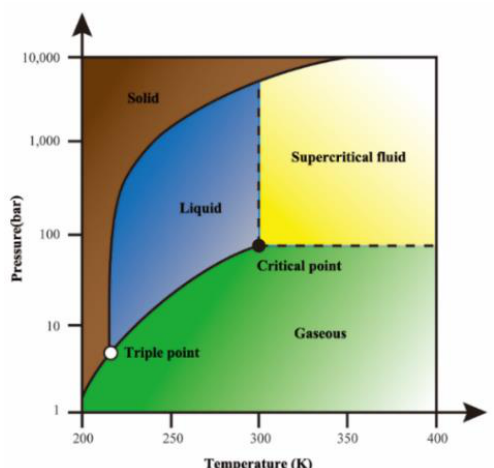
Figure 2. Phase diagram of carbon dioxide.